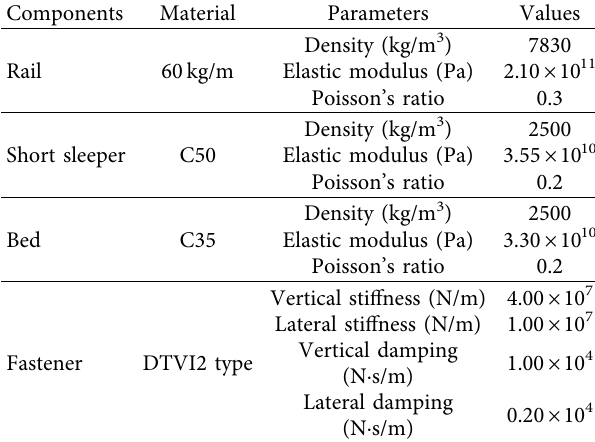
Table 2: Material parameters of components in ordinary slab